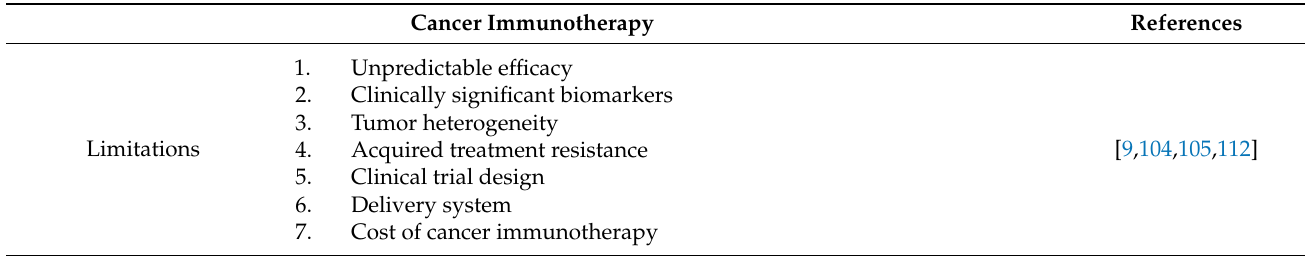
Table 2. The limitations, challenges, and solutions of cancer immunotherapy. Cancer